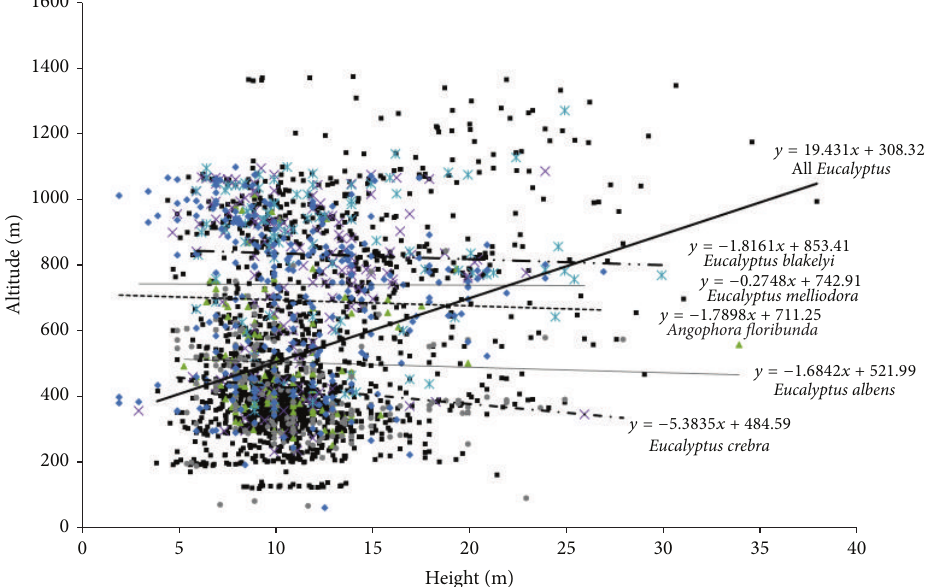
Figure 5: Change in average tree height of all Eucalyptus species within site (interspecific variation) and the average height of five selected widespread species (intraspecific variation) against the altitude gradient. Note there is a small negative change in the average tree heights of individual species with increasing altitude. Overall there is an increase in the height of the summed Eucalyptus scores for each site.